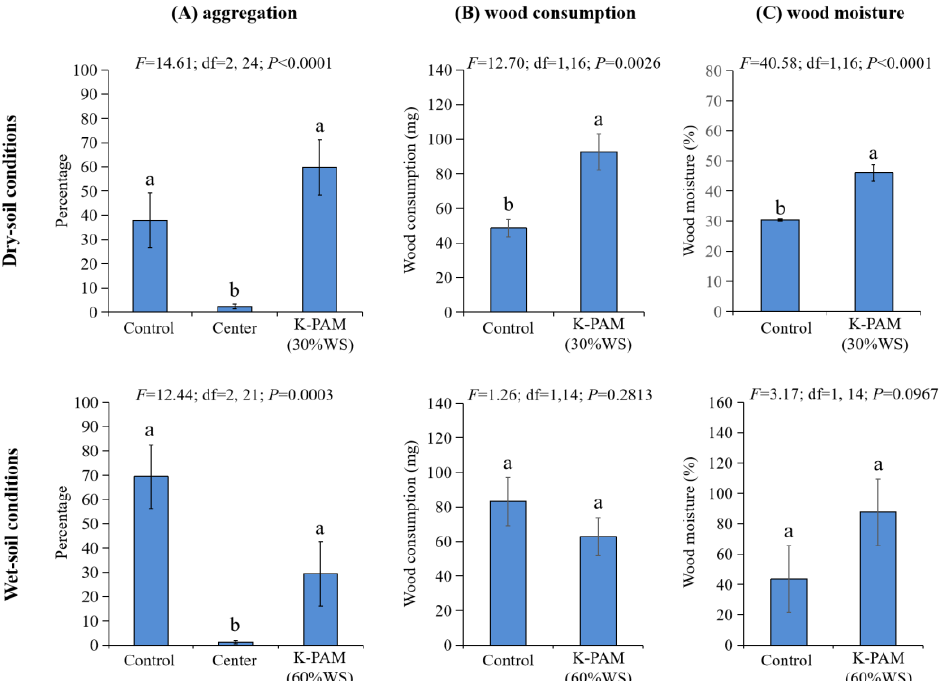
Figure 4. Results of the two choice tests (under dry- or wet-soil conditions) to investigate the preference of termites to potassium polyacrylate (K-PAM) placed within soil. Percentage of termites in each chamber ( A ), and wood consumption ( B ) and wood moisture ( C ) in the side chambers are presented as mean ± SE. Different letters indicate significant differences ( p < 0.05). WS represents water saturation level.